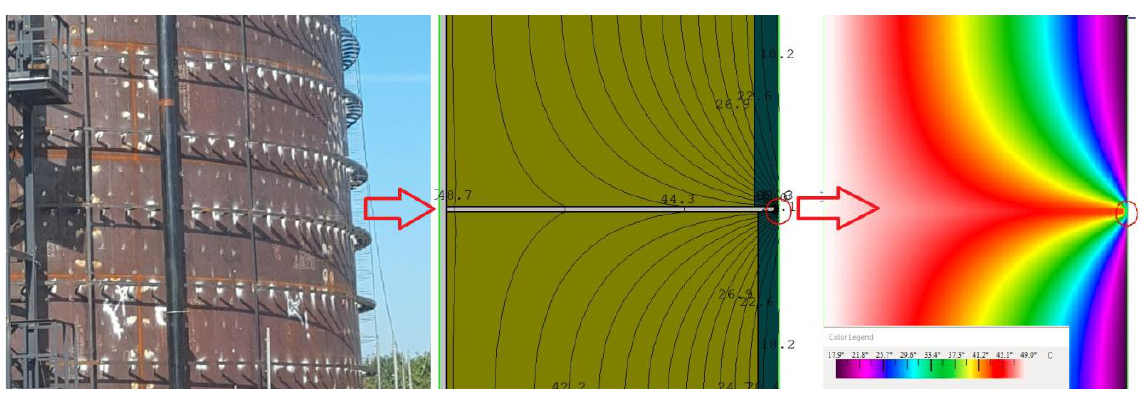
Figure 7. Heat loss modeling for cotton wool mounting nails using THERM program